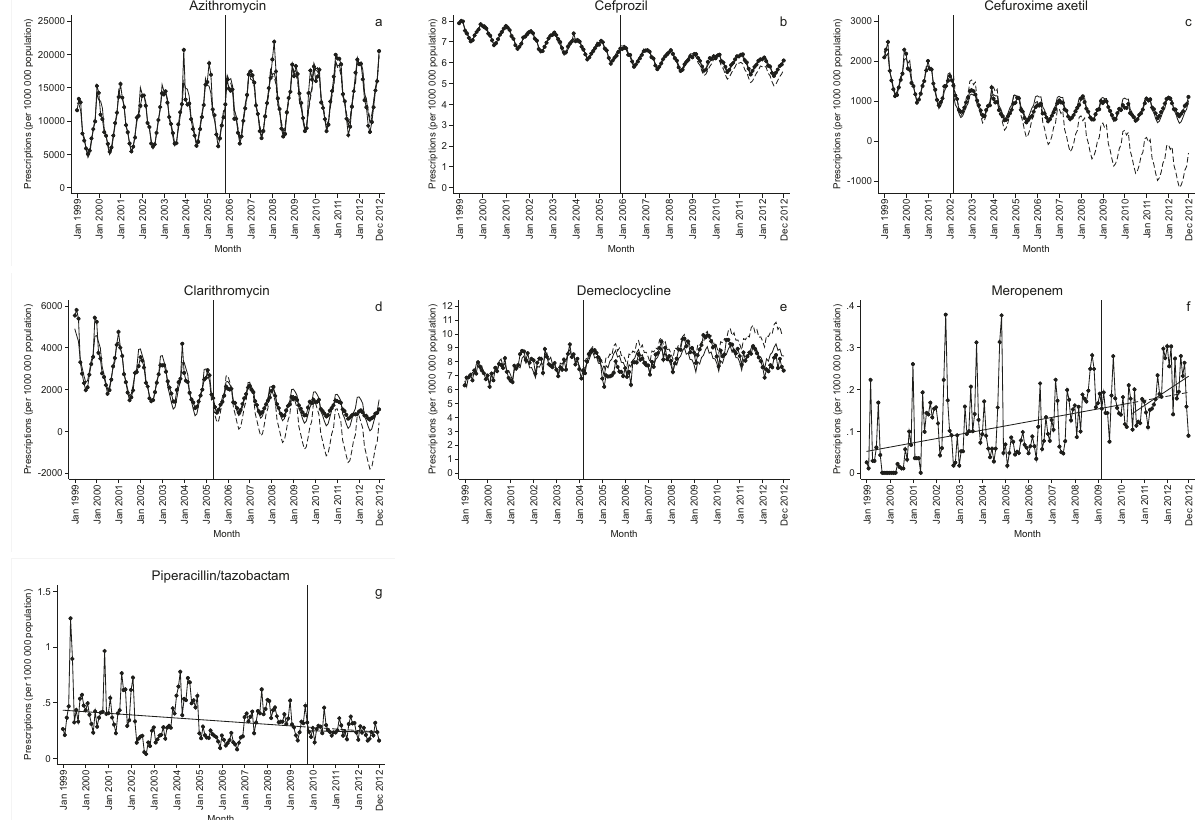
Fig. 2 Antibiotics showing no signi fi cant level change within two years after generic entry. Change in number of antibiotic prescriptions per one million population before and after generic entry (vertical line), with projected level of prescriptions if generic entry had not taken place (dashed line). a Azithromycin. b Cefprozil; note logged data. c Cefuroxime axetil. d Clarithromycin. e Demeclocycline. f Meropenem. g